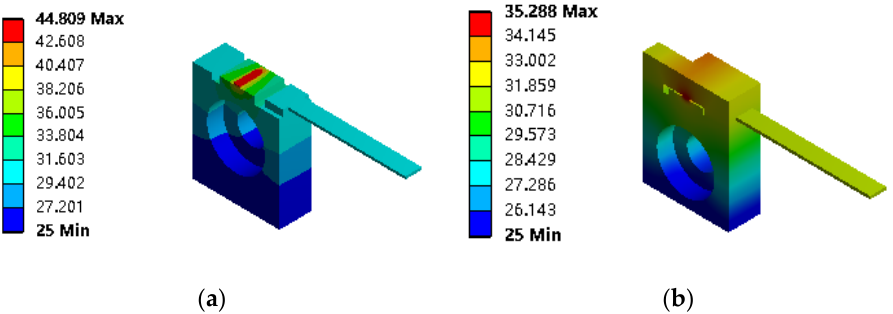
Figure 6. C-type and DC-type package temperature distribution diagrams. ( a ) C-type package temperature diagram and ( b ) DC-type package temperature diagram.